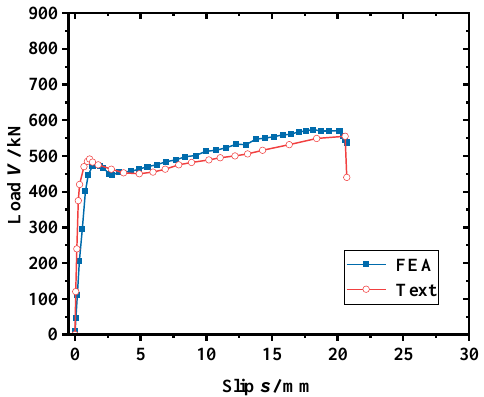
Figure 7. Comparison of load – slip curve.